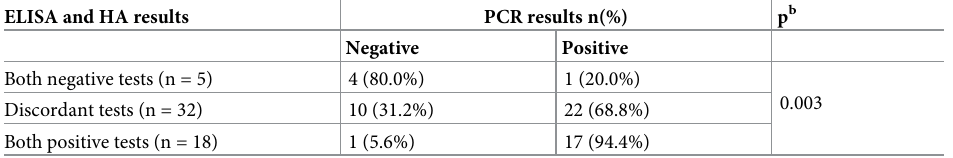
Table 5. Serum PCR performance according to combined ELISA and HA serological tests among patients with positive WB (N = 55 a ). ELISA and HA results